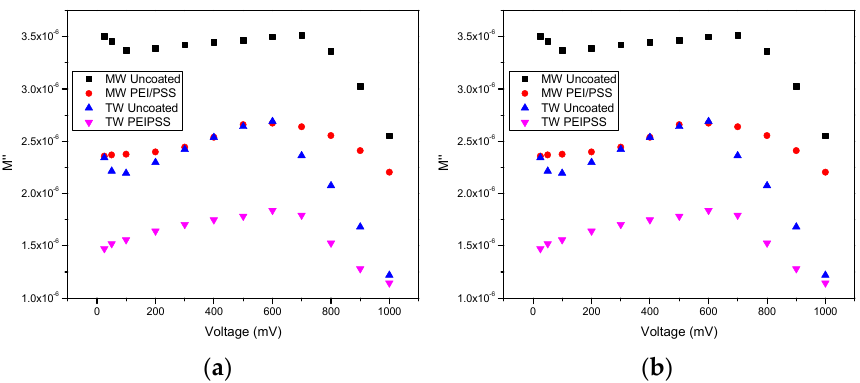
Figure 5. Plots of the ( a ) capacitance and ( b ) imaginary component of the electrical modulus (M’’) as functions of the varying voltage applied to the sensors (uncoated and with a (PEI/PSS) 5 thin film) in both types of water, MW and TW, for 1 Hz and 2 × 10 5 Hz, respectively. The relative error is less than 1%.